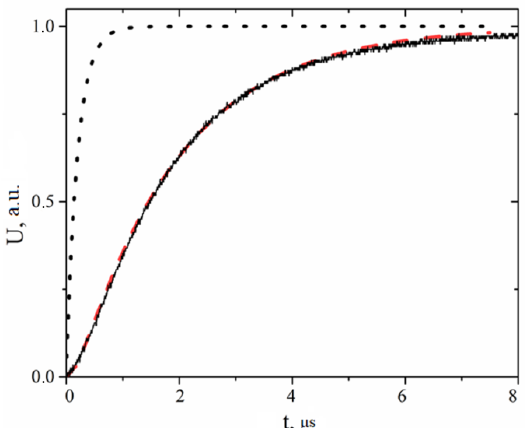
Figure 13. Output signal (solid line) dependence on time for voltage applied to optocoupler (dot) through 14 k Ω resistor. Dashed line indicates exponent with τ = 1.8 μ s, see also [12] (Reprinted with permission, Copyright 2018 Pleiades Publishing, Ltd.).